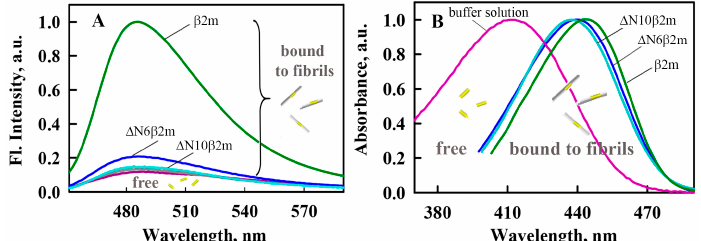
Figure 3. Spectral properties of thioflavin T (ThT) bound to β 2M amyloid fibrils. ( A ) Fluorescence spectra of free ThT in water solution (purple curve) and the dye in the presence of β 2m monomer (gray curve) and amyloid fibrils formed from β 2m (green curve), ∆ N6 β 2m (blue curve) and ∆ N10 β 2m (cyan curve). ( B ) Absorption spectra of ThT bound to β 2M amyloid fibrils determined with the use of solutions prepared by the equilibrium microdialysis. Absorption spectra of free ThT in water solution (purple curve) and the dye bound to β 2m (green curve), ∆ N6 β 2m (blue curve) and ∆ N10 β 2m (cyan curve) amyloid fibrils are shown. All presented spectra normalized to unity at the spectral